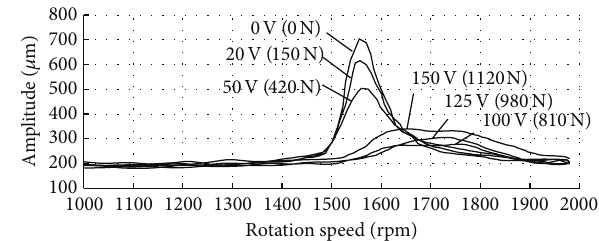
Figure 14: The Bode curves of the rotor system with various damping force applied from the beginning to the end of the rotor running